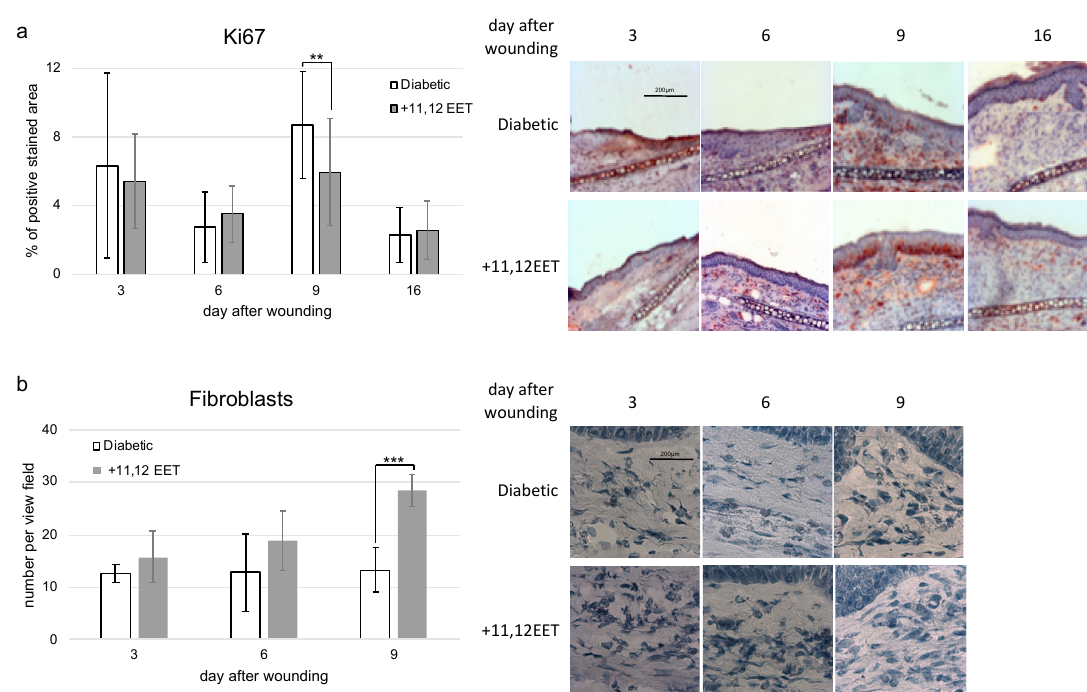
Figure 5. ( a ) Percentage of Ki-67-positive area on days 3, 6, 9, and 16 after wounding of diabetic mice without and after treatment with 11,12 EET; on the right, representative pictures of the staining. ( b ) Number of fibroblasts in the wound margin on days 2. 6, and 9 after wounding of diabetic mice without and after treatment with 11,12 EET; on the right, representative pictures of the staining. (Data are shown as mean ± SD; n = 14 ) ** p ≤ 0.01, *** p ≤ 0.001